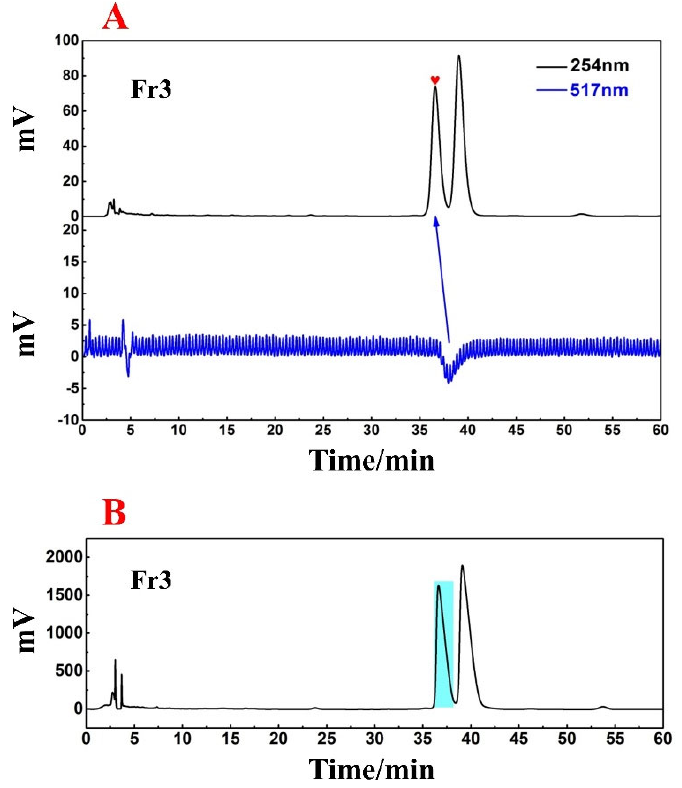
Figure 4. Online HPLC − DPPH detection chromatogram of Fr3 ( A ); preparation chromatogram of Fr3 ( B